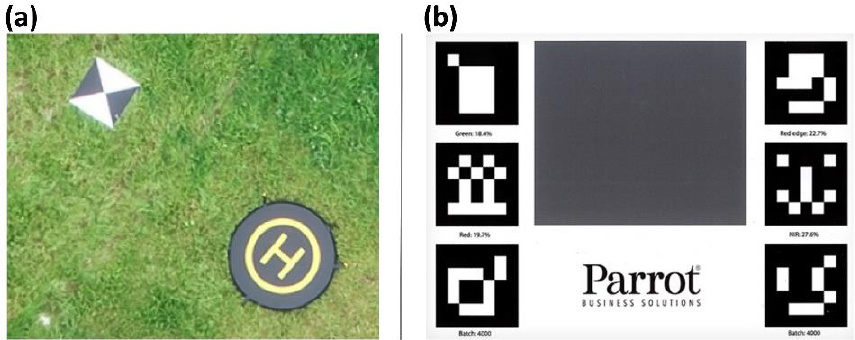
Figure 2. The left panel ( a ) is a zoom onto the RGB orthophotomosaic from DJI Mavic pro 2 Platinum (1 cm ground resolution) centered on a ground control point (GCP; 0.5 m plastic square), used to ensure geometric calibration, as well as the take-o ff and landing device. The black and white pattern of the GCP allows for automatic location by the photogrammetric software used in the study. The right pannel ( b ) represents the white balance card used to perform radiometric